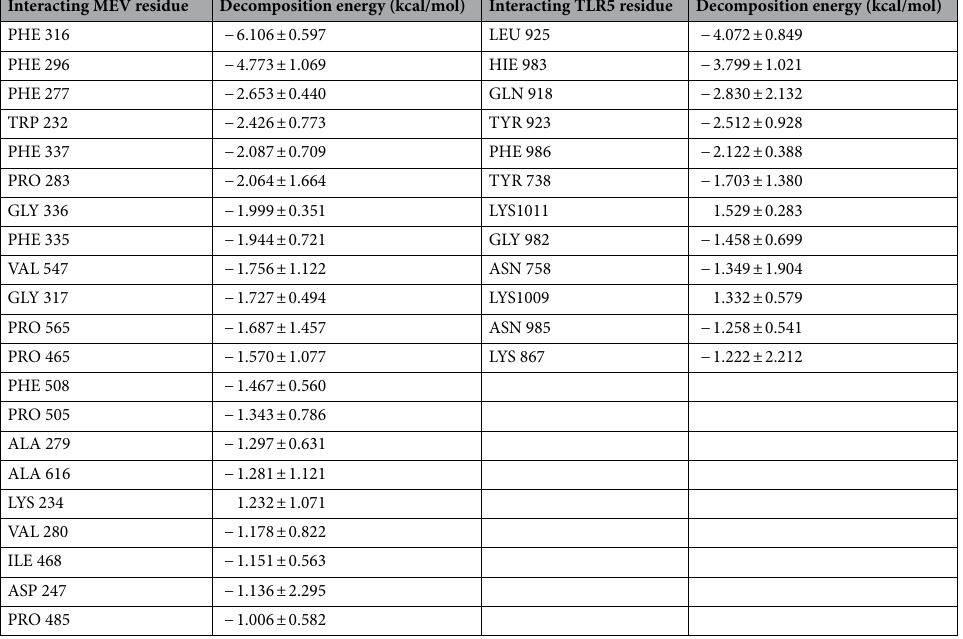
Table 5. Energy decomposition of the interacting residues of MEV_TLR5 complex during molecular dynamic simulation.